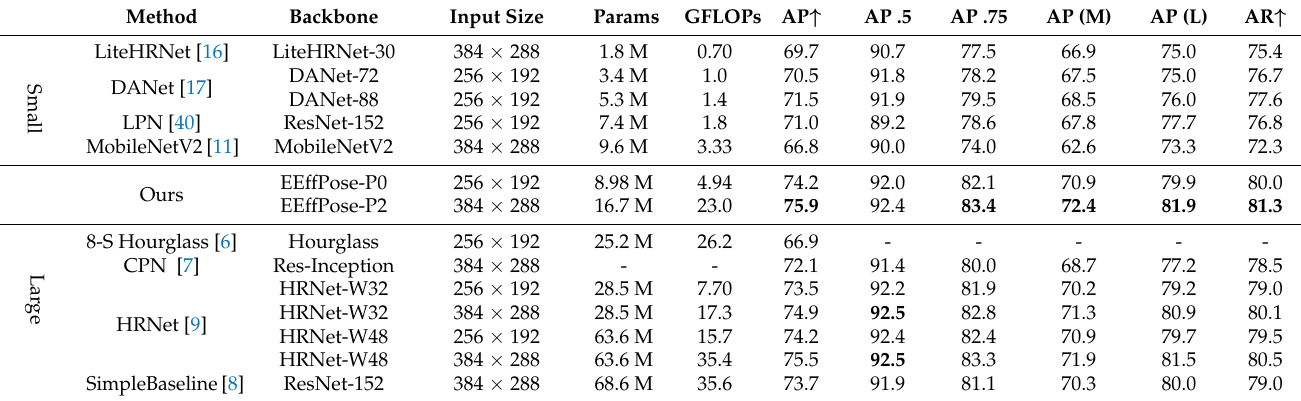
Table 3. Comparisons to the state-of-the-art on the COCO test